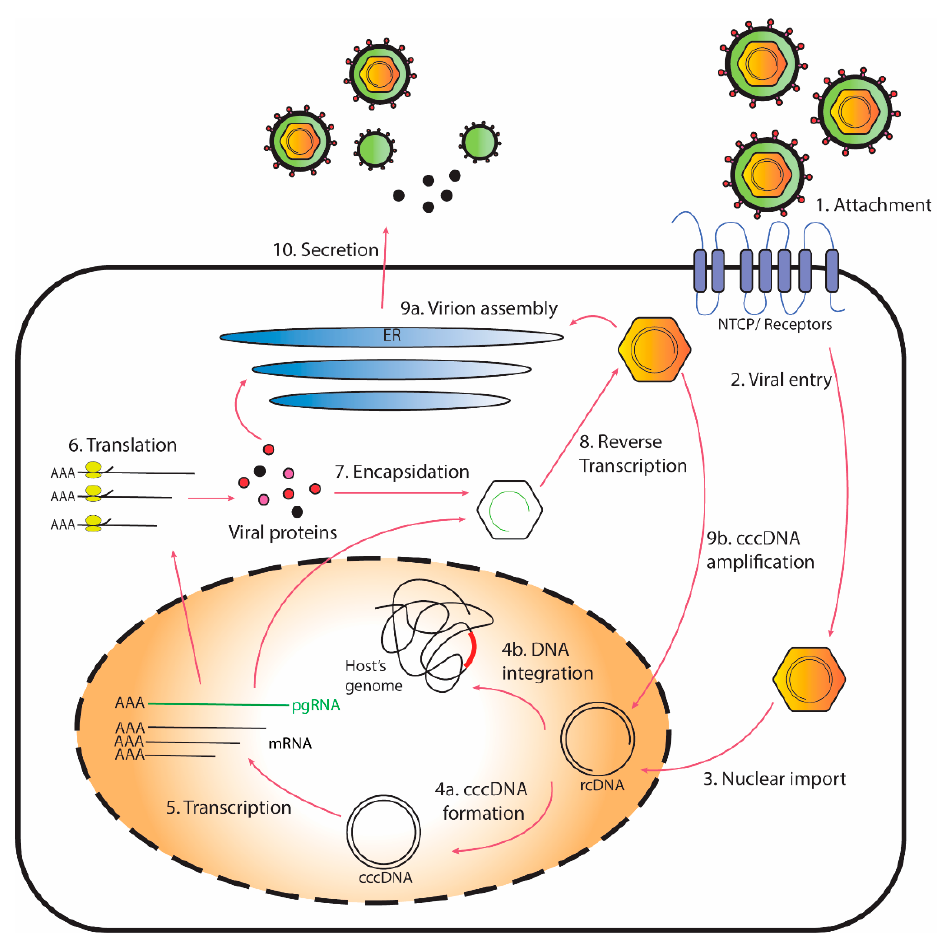
Figure 1. Schematic representation of the hepatitis B virus (HBV) life cycle.